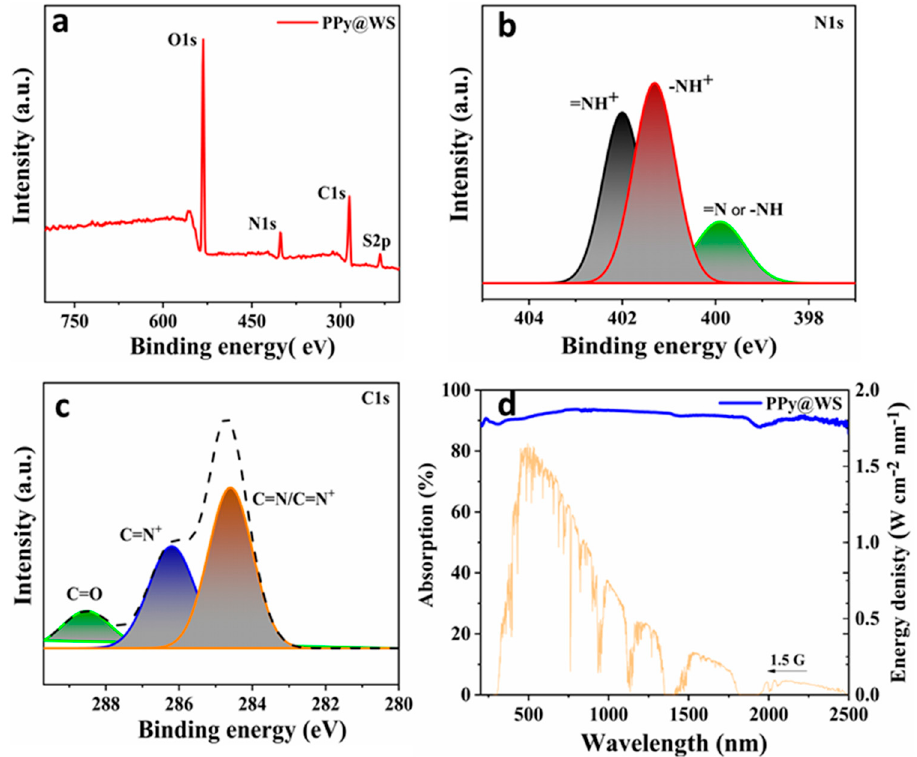
Figure 3. Chemical states of in situ polymerized PPy NPs at the top surface of wood pulp sponge. ( a ) XPS survey of PPy@WS solar evaporator. ( b ) N1s spectra and ( c ) C1s spectra of PPy@WS solar